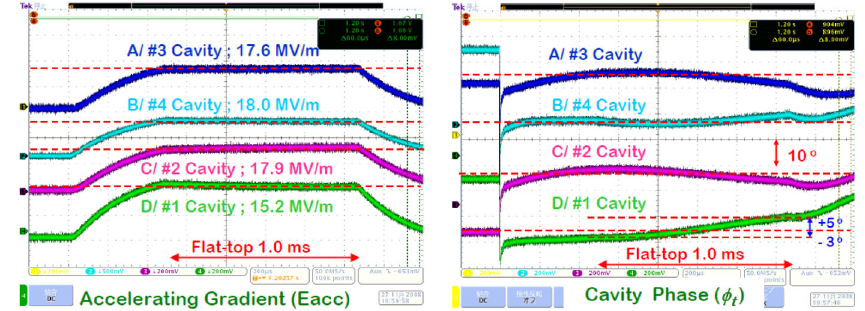
FIG. 25. (Color) The rf pulse signals of accelerating gradient (left) and cavity phases (right) in four-cavity operation with vector-sum control without a piezo drive pulse. Red broken lines show the constant accelerating gradient at flattop (left) and datum line of the standard cavity phase (right).